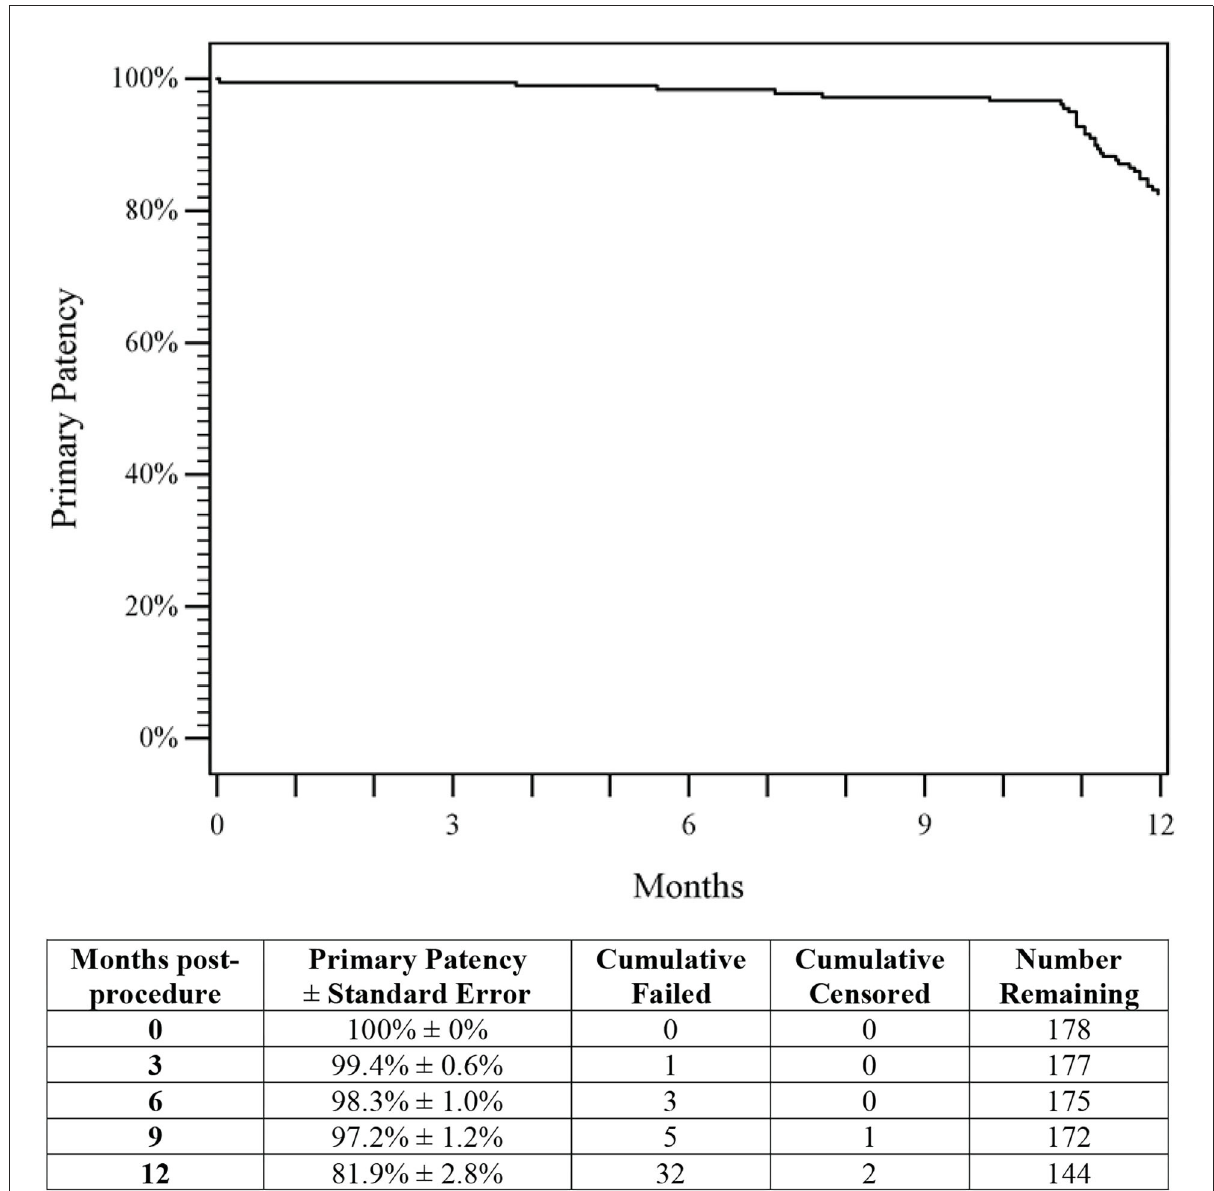
FIGURE2 Primary patency. The Kaplan–Meier curve shows an 81.9% rate of primary patency through 1-year for patients treated with DES. The life table is included. DES, drug-eluting stent.